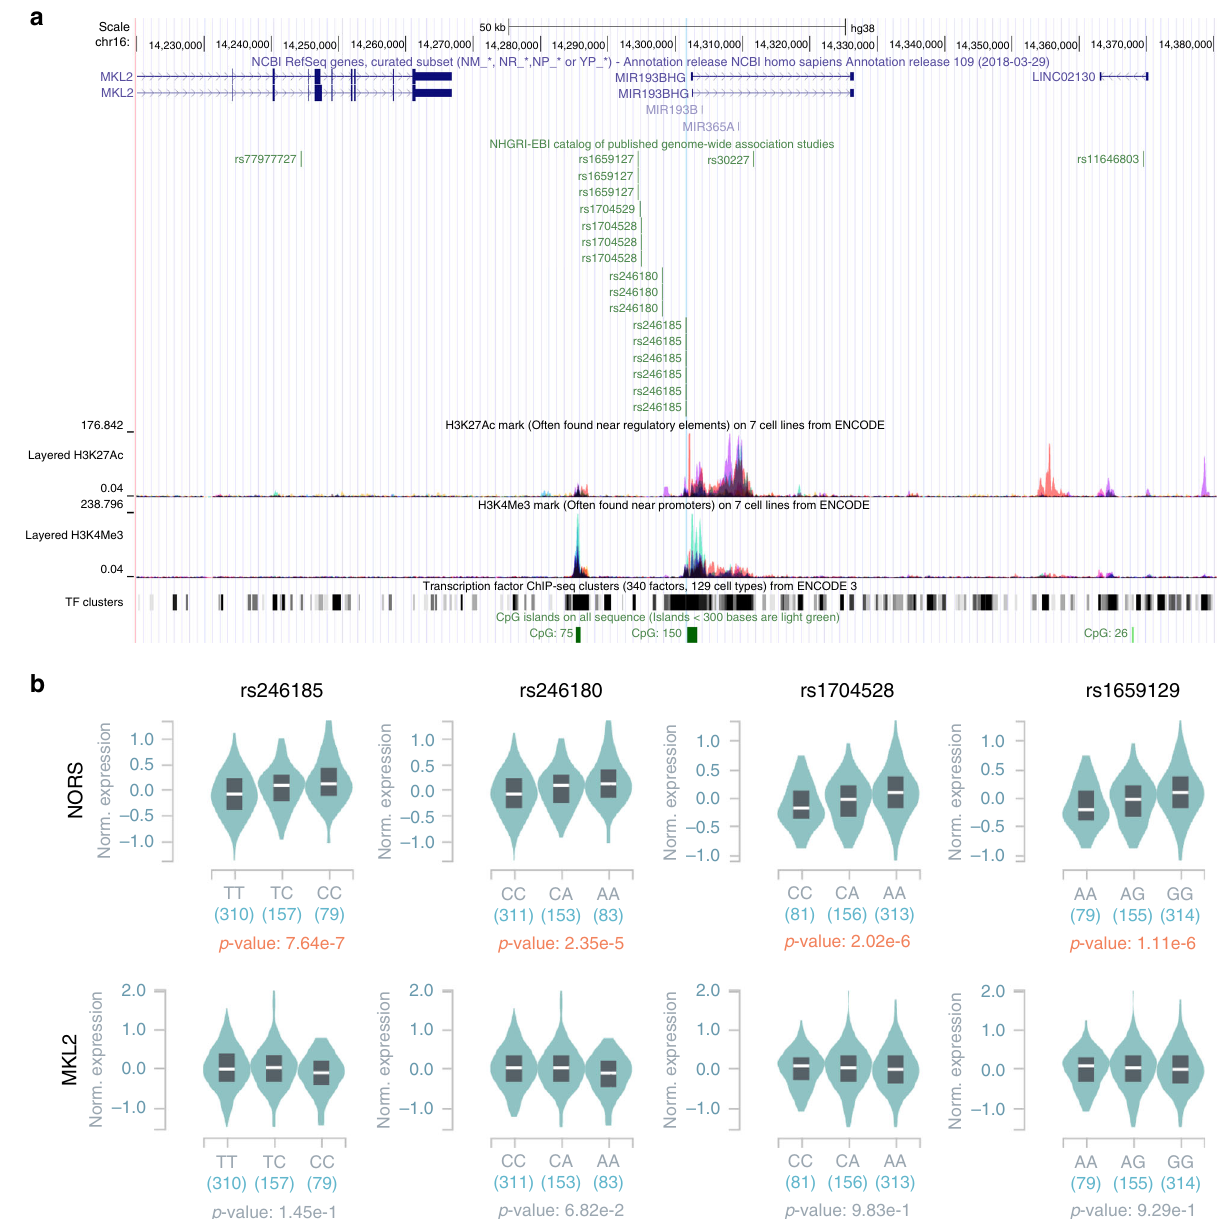
Fig. 7 GWAS-reported SNPs in lincNORS promoter support its roles in steroid regulation. a Locations of SNPs in lincNORS promoter reported in NHGRI- EBI catalog of published genome-wide association studies were visualized in UCSC genome browser. b eQTL boxplot showing genotype-expression relationships between rs246185, rs246180, rs1704528, and rs1659129 with lincNORS (top) or the closest protein-coding gene MKL2 (bottom) in skeletal